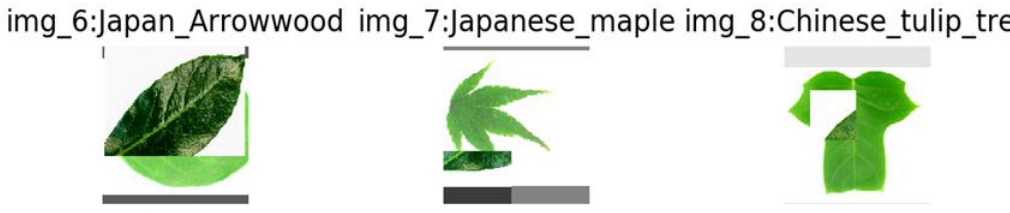
Figure 16. CutMix results from the Flavia dataset.